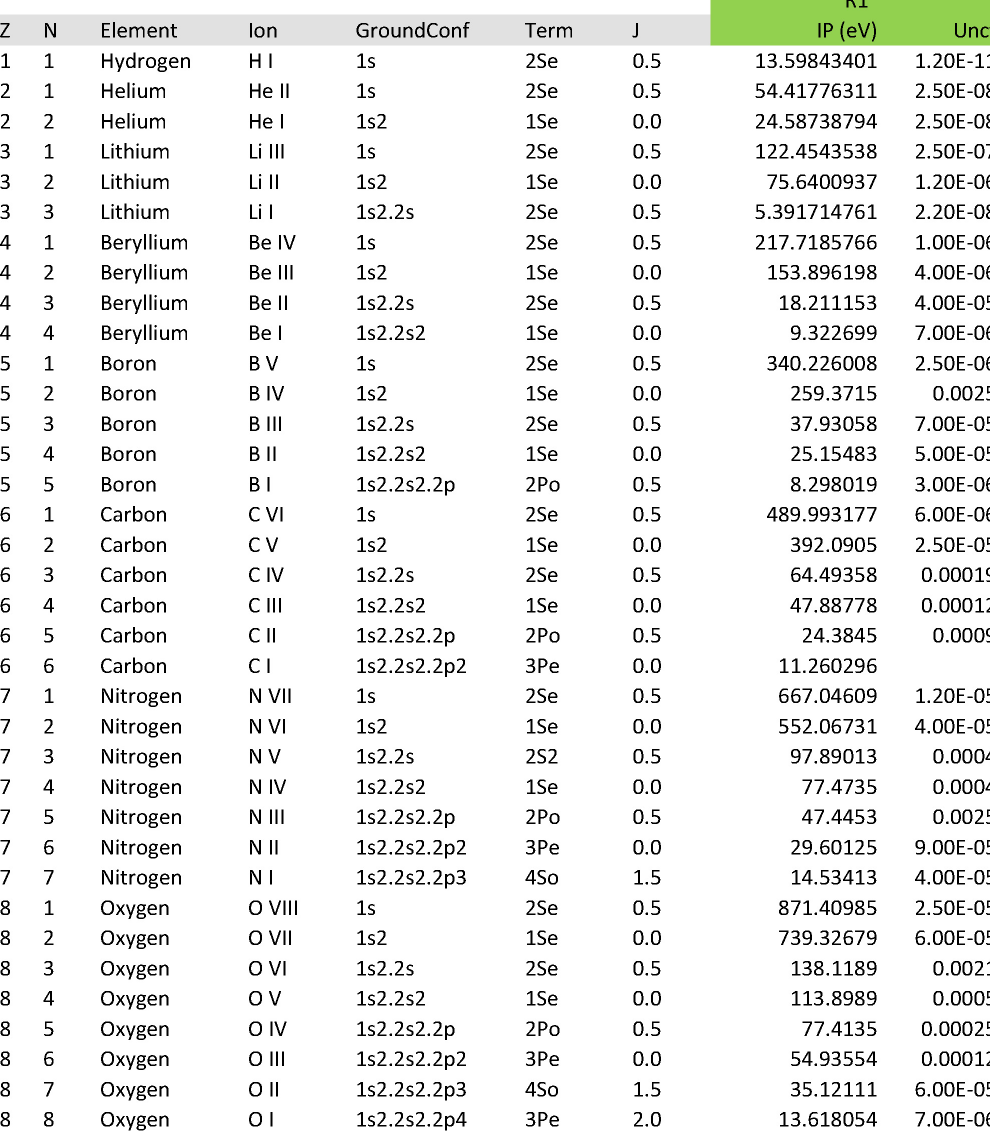
Figure 3. Google reference sheet ions of AtomPy listing NIST ionization potentials (IP) for elements with Z ≤ 110 (only those with Z ≤ 8 are displayed). Note that IP uncertainties are also